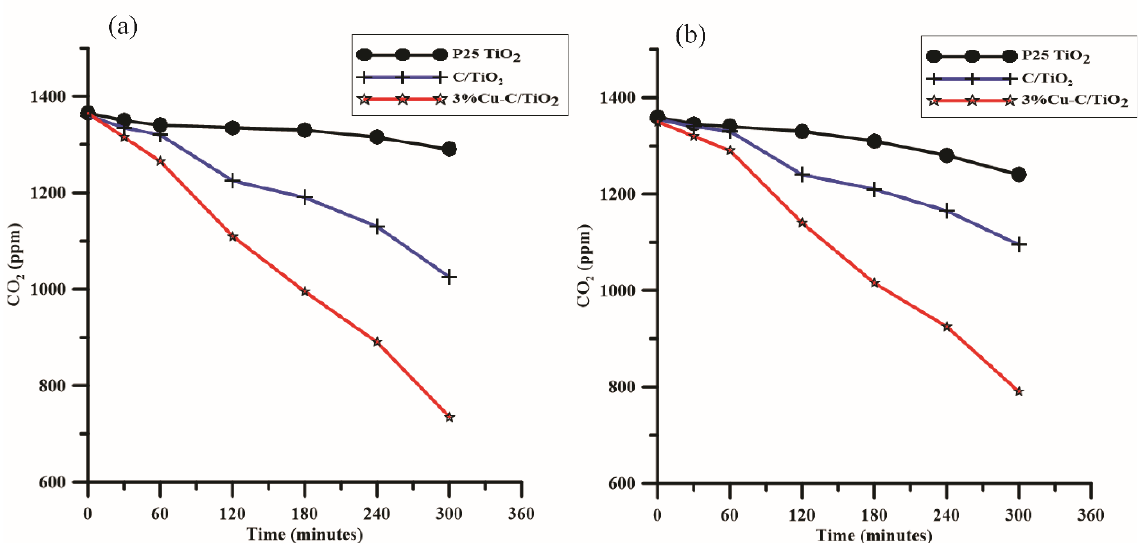
Figure 7. Time dependence on the photocatalytic reduction of CO